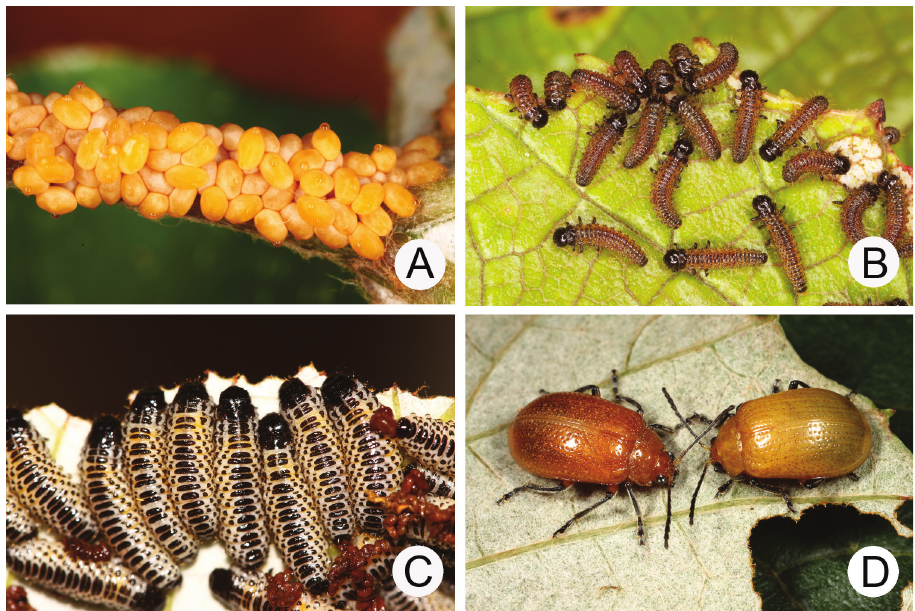
Figures 8. Field photographs of Gallerucida lutea Gressitt & Kimoto. A Egg mass B Early instar larvae C Mature larvae D